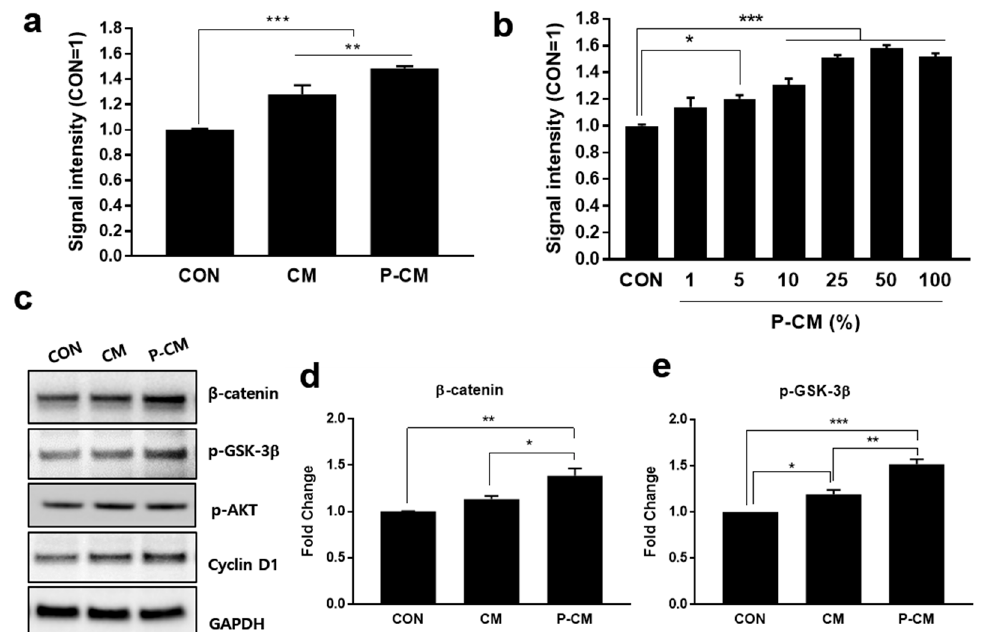
Figure 1. Primed CM (P-CM) induced the viability of DPCs and increased the expression of β -catenin and p-GSK-3 β [SER9]. DPCs were treated with 25% CM and P-CM in DMEM for 48 h. DPCs were cultured in DMEM medium without supplementation as a control. ( a ) The cell viability of the DPCs, which was evaluated by the CCK-8 assay, was significantly increased after treatment with 5% P-CM. ( b ) The data shows that the viability of DPCs increased with an increasing P-CM concentration. ( c – e ) Western blot analysis: After treating DPCs with 25% CM or P-CM for 48 h, cell lysates were collected and subjected to western blot analysis with specific antibodies. β -catenin and p-GSK-3 β [SER9] expression in P-CM-treated DPCs was significantly increased. In addition, there was also an increase in p-AKT and cyclin D1 in P-CM-treated cells. The data are reported as the fold change in comparison to the control group (CON). Data represent the mean ± SD. Each experiment was repeated at least three times. Statistically significant di ff erences were determined by one-way nonparametric ANOVA. * p < 0.05, ** p < 0.01, and *** p < 0.001. Abbreviations: CON, raw Dulbecco’s modified Eagle’s medium (DMEM); CM, mesenchymal stromal cell (MSC)-derived conditioned medium; P-CM, primed MSC-derived conditioned medium; DPCs, follicle dermal papilla